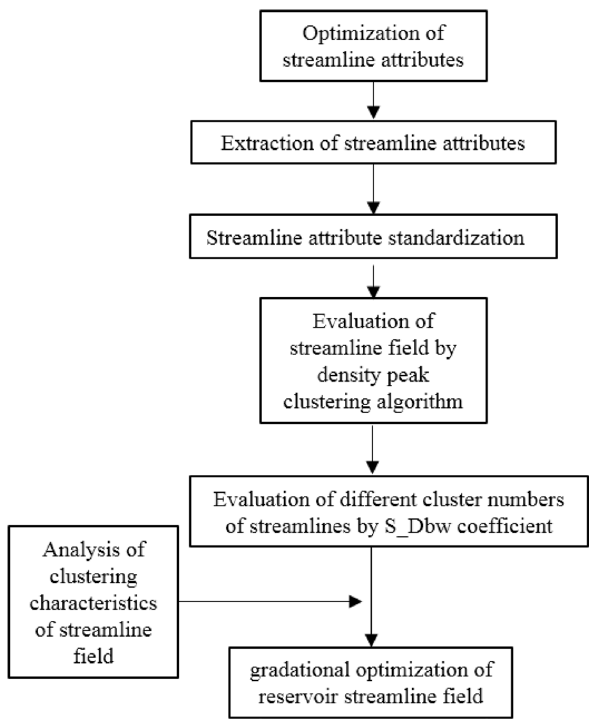
Fig. 3 Application of the peak density clustering algorithm to evalu- ate the streamline field